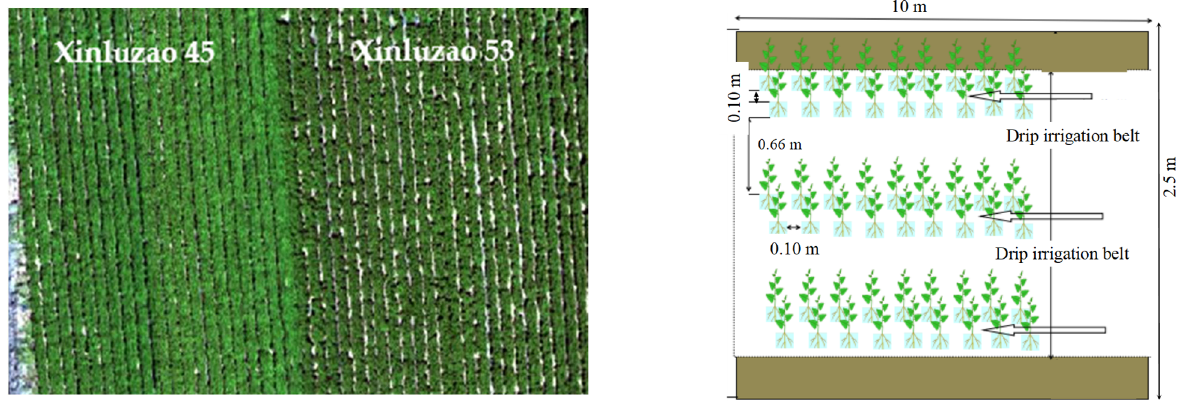
Figure 2. The top view of cotton test area ( left ) and internal row spacing configuration diagram of cotton field experimental community ( right